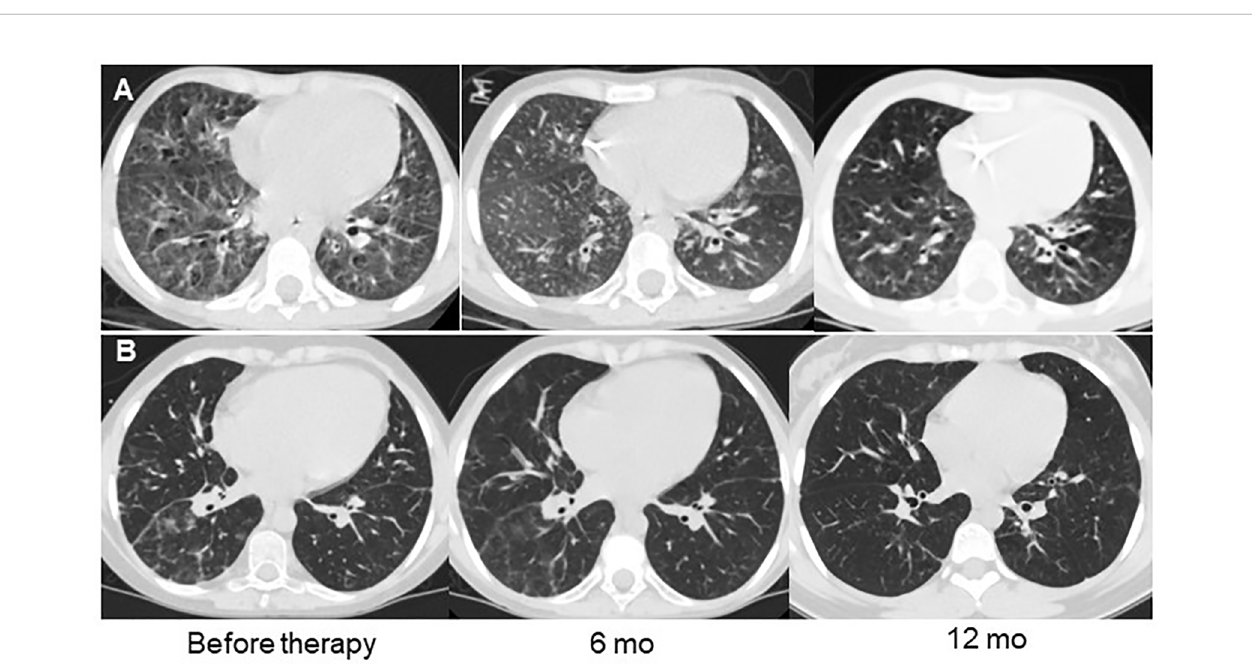
FIGURE 5 | Examples of lung CT dynamics in the course of abatacept therapy. (A) – P28 with CTLA4 de fi ciency, (B) – P27 with